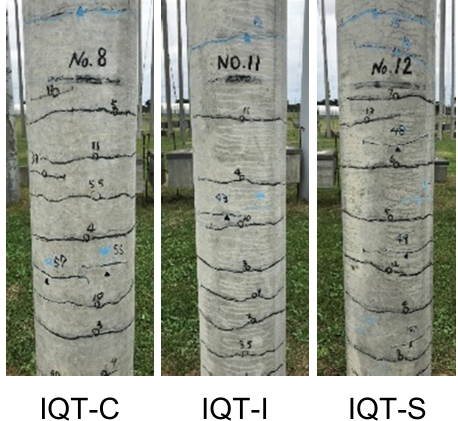
Figure 8. Delayed fracture resistance evaluation us- ing quasi-FIP test.